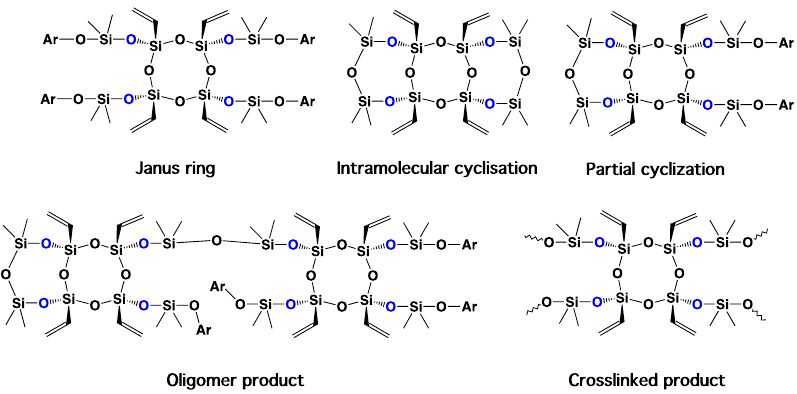
Figure 1. The structure of target product and possible by-products, including the partial intramo- lecular cyclization product, intramolecular cyclization product (tricyclic laddersiloxane), and crosslinked product.